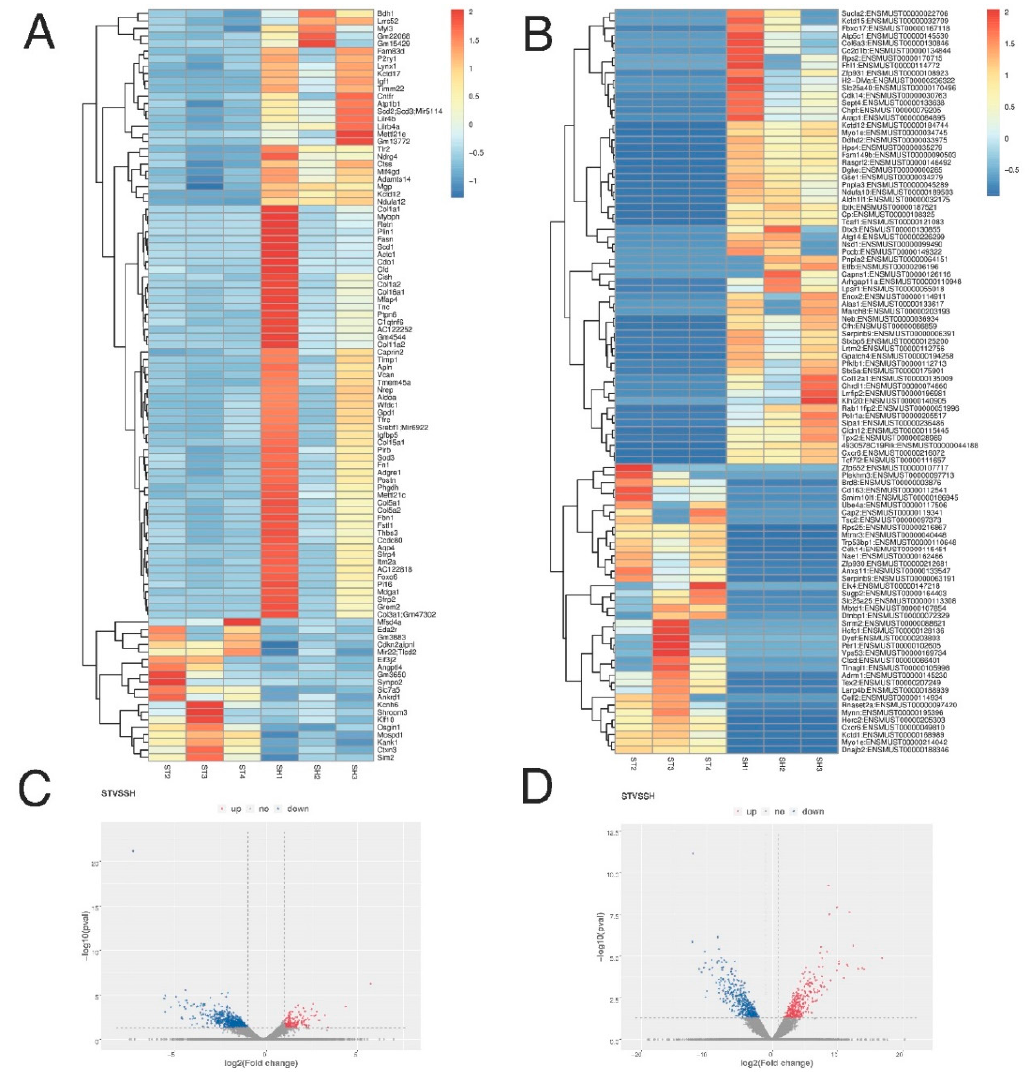
Figure 5. Heatmaps and volcano plots of differentially expressed genes (A and C) and transcripts (B and D).